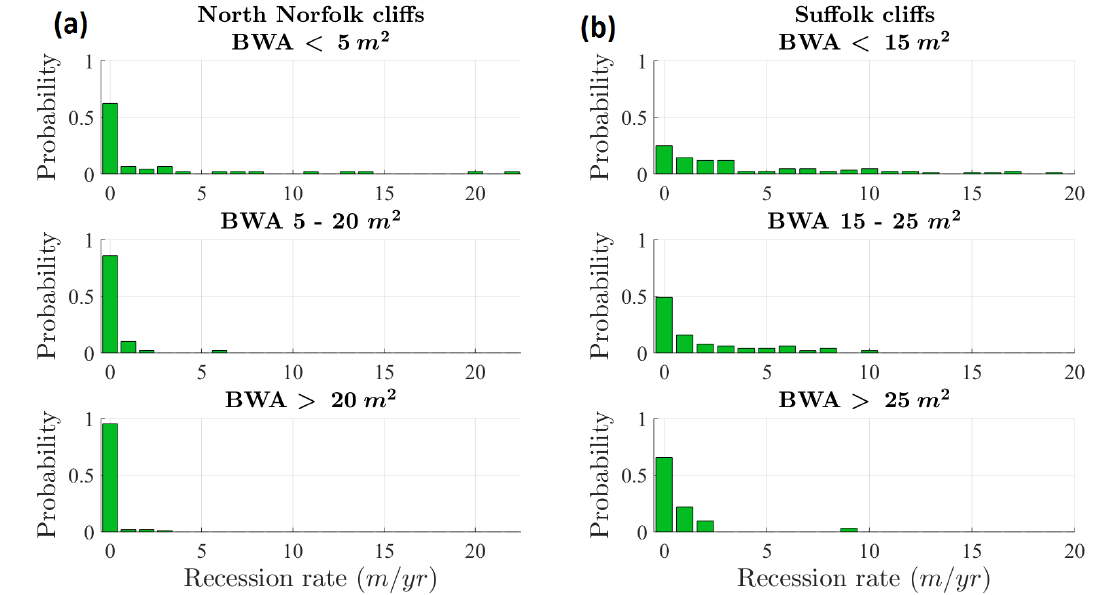
Figure A5. Annual Scale probability distribution for cliff top recession rates sub-divided into different BWA ranges based on the data according to [3] for North Norfolk ( a ) and Suffolk ( b ) cliffs. The probability histogram is based on intervals of 1 m/yr for cliff top recession rates.